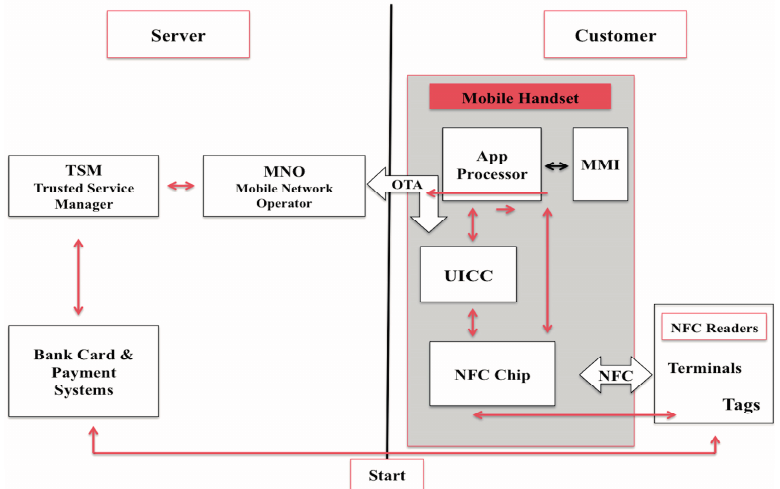
Figure 4. Payment process through NFC smartphones applets (source: authors’ elaboration based on [36]).